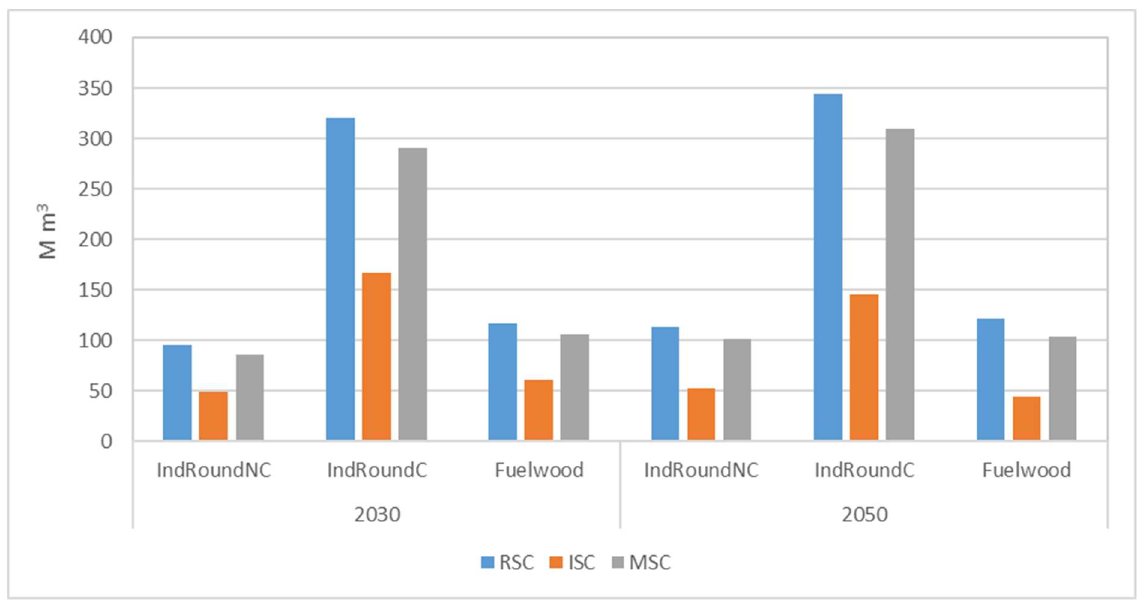
Figure 3. EU roundwood production by wood types in RSC (blue), ISC (orange) and MSC (grey). IndRoundNC and IndRoundC refers to non-coniferous and coniferous industrial roundwood, respectively [authors’ results].